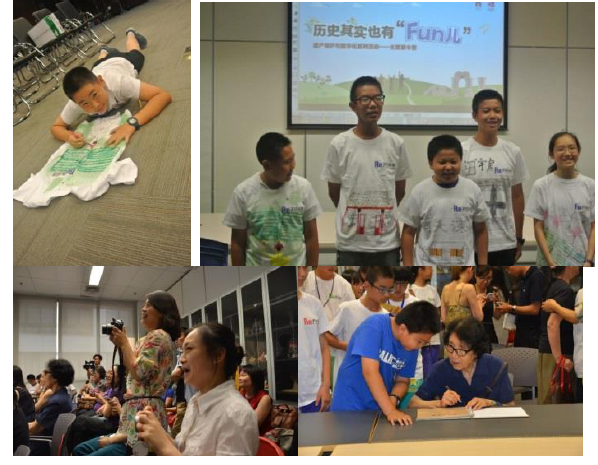
Figure 6. The Presentation Section of the “ History Is